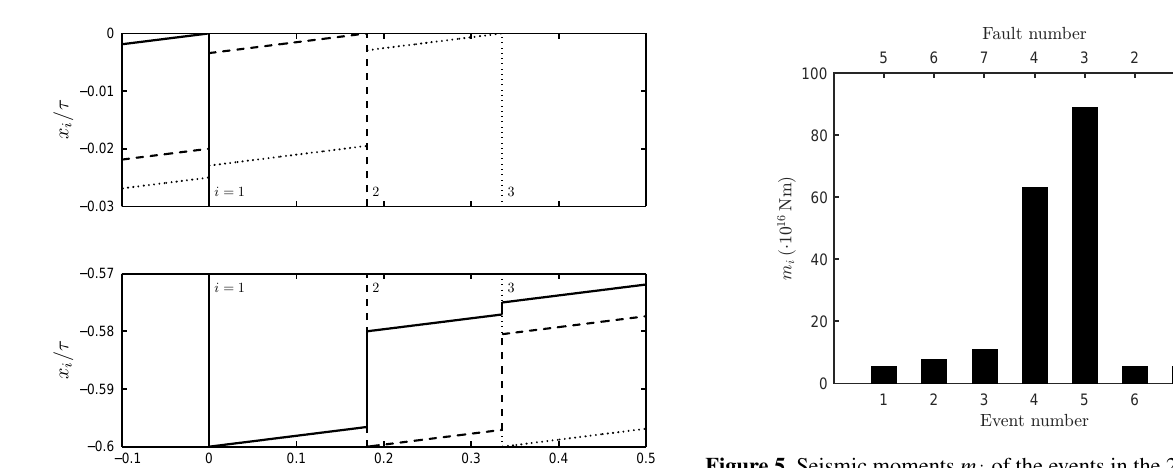
Figure 5. Seismic moments m i of the events in the 2012 Emilia se- quence. The upper scale indicates the fault number, the lower scale the order of activation. The two strings of numbers yield the permu- tation α ∗ in Eq.